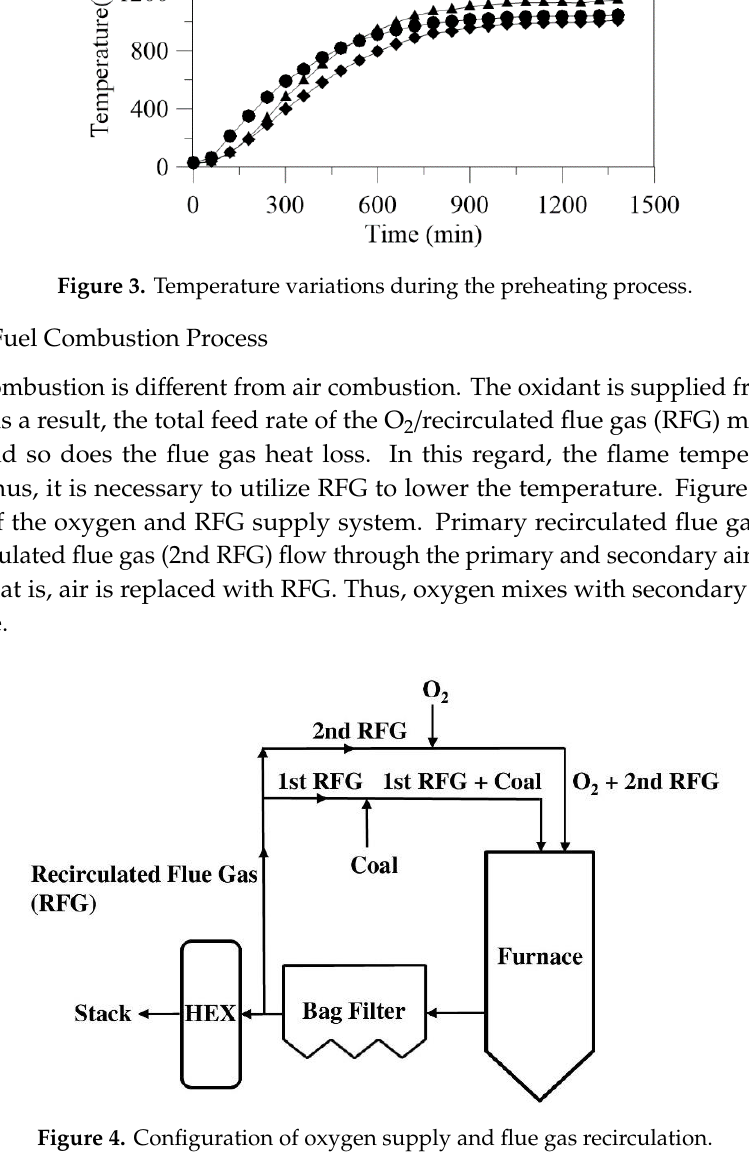
Figure 4. Configuration of oxygen supply and flue gas recirculation.